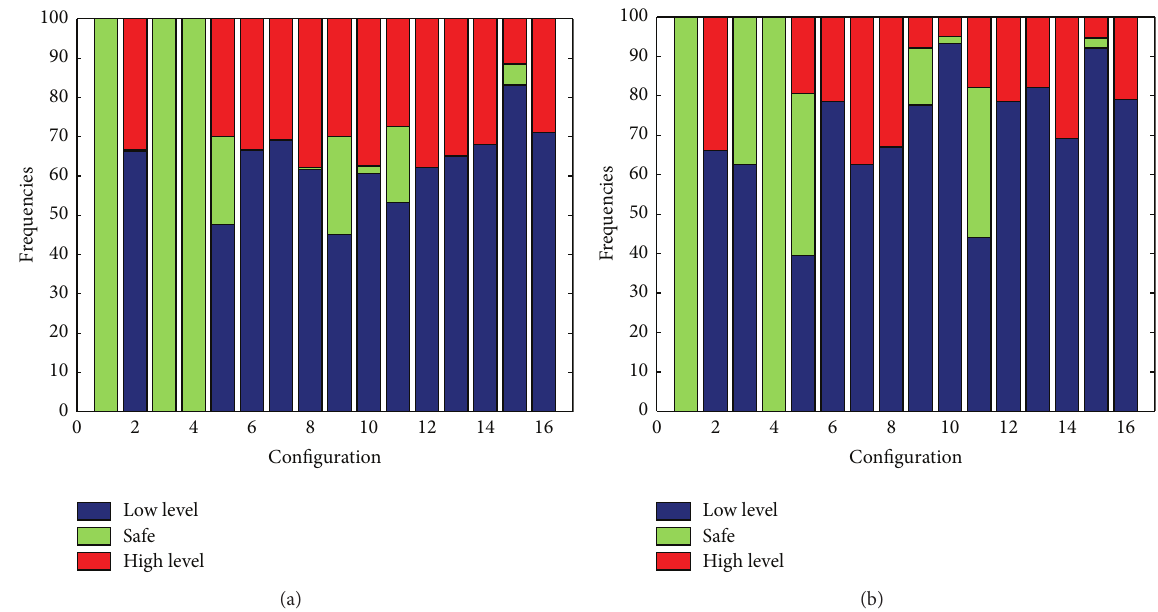
Figure 6: Histograms for high power level (a) and low power level (b) of the frequencies of occurrence of the end states for each of the 16 system configurations of Table 2, simulated by sampling discrete failure times and magnitudes of components